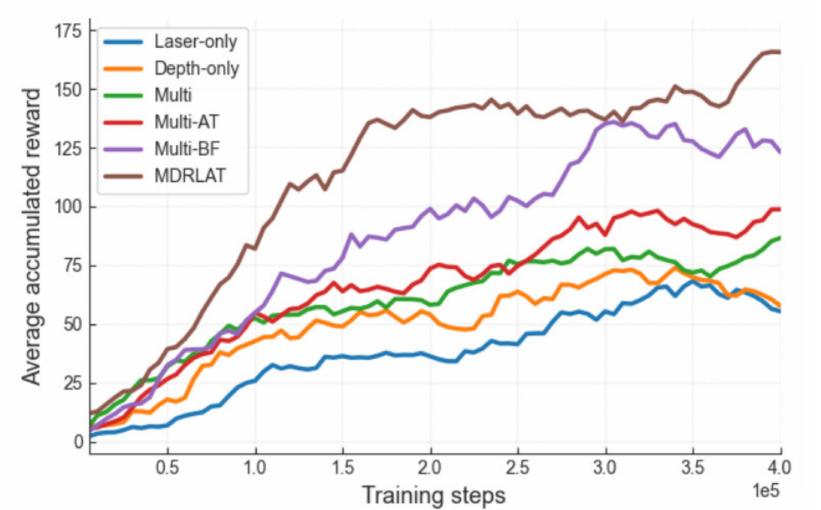
Figure 4. Smoothed training curves of average accumulated rewards obtained by each method at different training steps. Laser-only, directly feed the feature representation extracted from two- dimensional (2D) laser range findings into dueling double deep Q-network (D3QN); depth-only, directly feed the feature representation extracted from depth images into D3QN; multi, directly concatenate the feature representations extracted from different sensor modalities; multi-AT, adopt the auxiliary task module in the multi method; multi-BF, adopt bilinear fusion (BF) module in the multi method; MDRLAT, our proposed method.